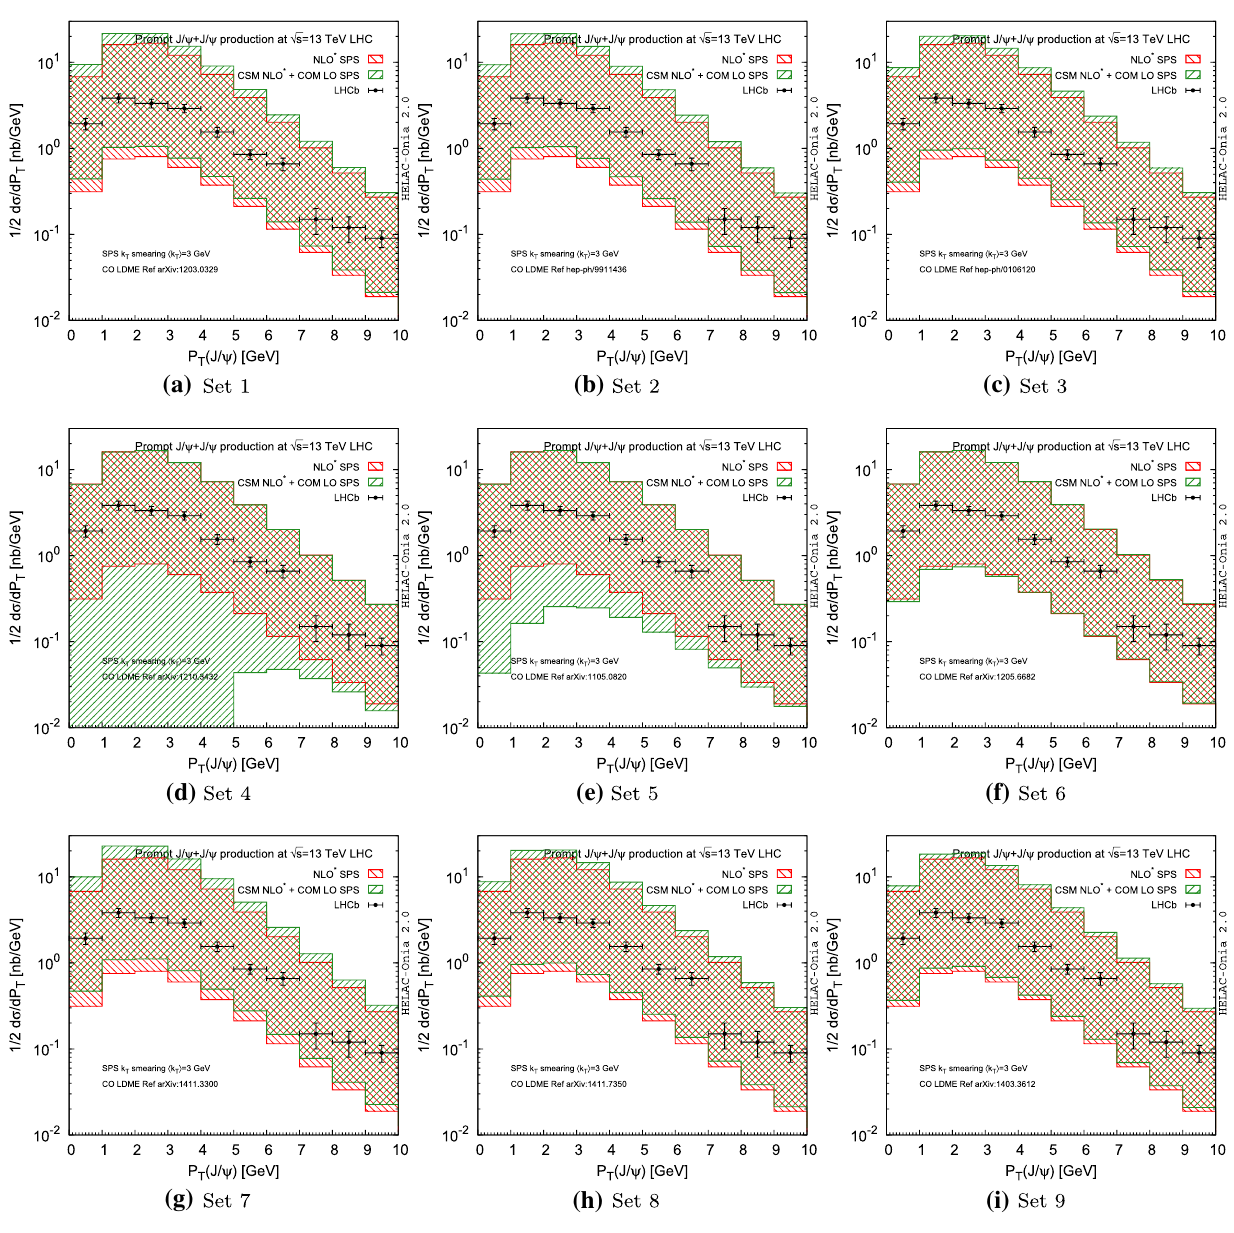
Fig. 16 P T ( J /ψ) distributions via SPS NLO (cid:11) CS and LO CO in the LHCb acceptance at